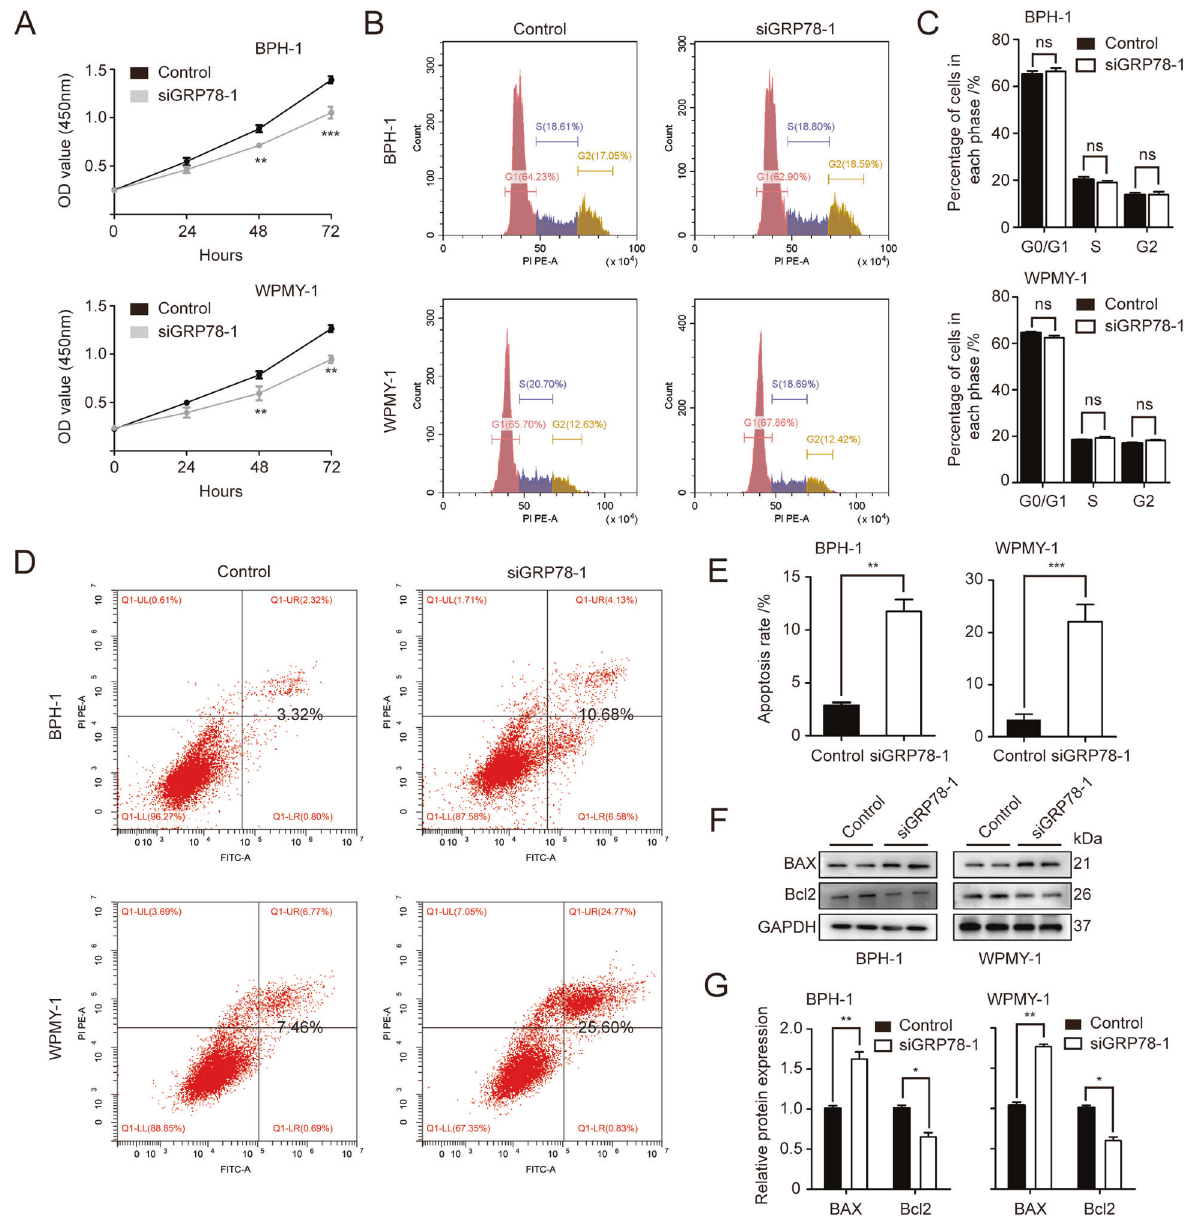
Fig. 2 GRP78 knockdown inhibits proliferation and induces apoptosis of prostate cells. A Cell viability (OD value (450 mm)) of BPH-1 and WPMY-1 cells after GRP78 KD at different time points (0, 24, 48, 72 h) by CCK8 assay. B Cell cycle detection for BPH-1 and WPMY-1 by fl ow cytometry analysis. The percentages (%) of cell populations at different cell cycle stages are listed within the panels C Statistical analysis for the cell percentage in each cell cycle phase. D Flow cytometry analysis of prostate cell apoptosis after transfected with either control siRNA (Control, left) or siGRP78 – 1 (right). PI PE-A in y-axis stands for the fl uorescence intensity of propidine iodide (PI), and FITC-A in x-axis stands for the fl uorescence intensity of Fluorescein isothiocyanate (FITC) labeled Annexin V. The apoptosis rate is represented by percentage of Annexin V + /PI + cells. E Statistical analysis for apoptotic rate (%) of both prostate cell lines. F , G Immunoblot assay and relative densitometric quanti fi cation of apoptosis-related proteins BAX and Bcl2 in GRP78-silenced prostate cells. GAPDH is used as loading control. ns: p > 0.05; * p < 0.05; ** p < 0.01; *** p <